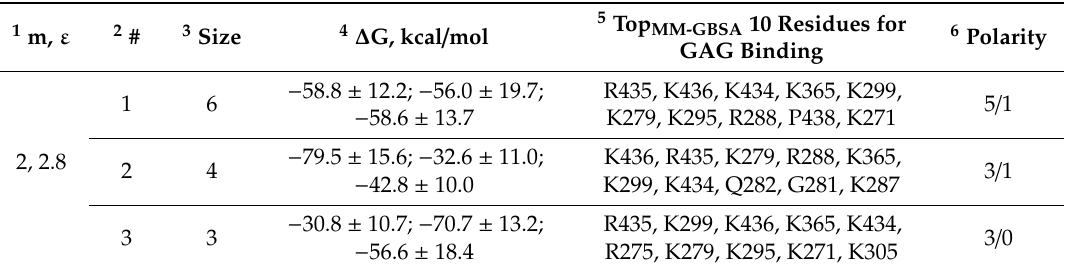
Molecular docking MD-based analysis summary for PCPE-1 SAXS Model / Ca 2 + / HP dp6 interaction.